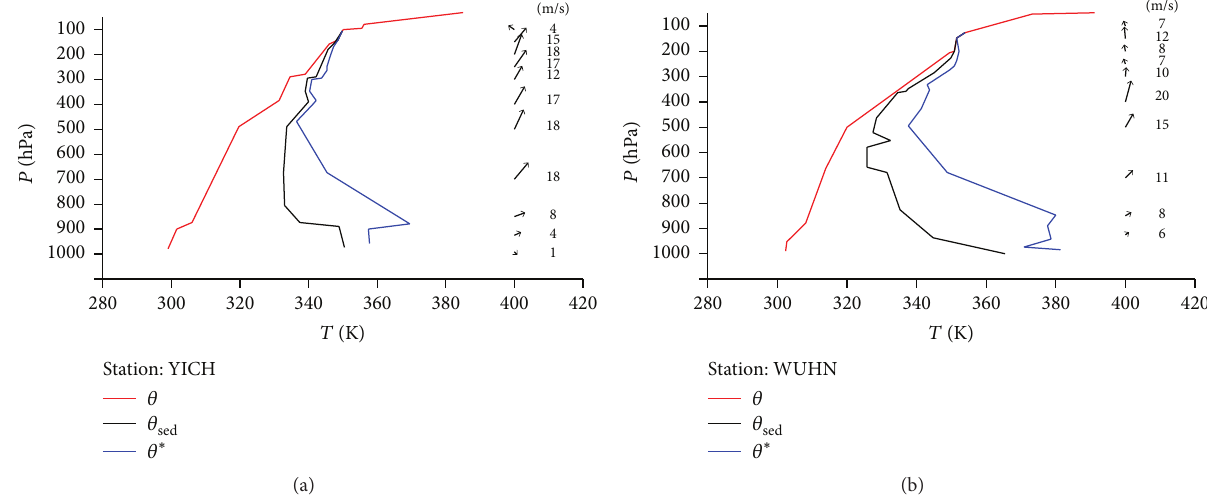
Figure 6: 𝑉 - 3𝜃 distribution conditions: (a) 8:00 p.m. on July 26, 2007, at the YICH station; (b) 8:00 p.m. on July 26, 2007, at the WUHN station. The red lines are the 𝜃 curves, the green lines are the 𝜃 sed curves, and the blue lines are the 𝜃 ∗